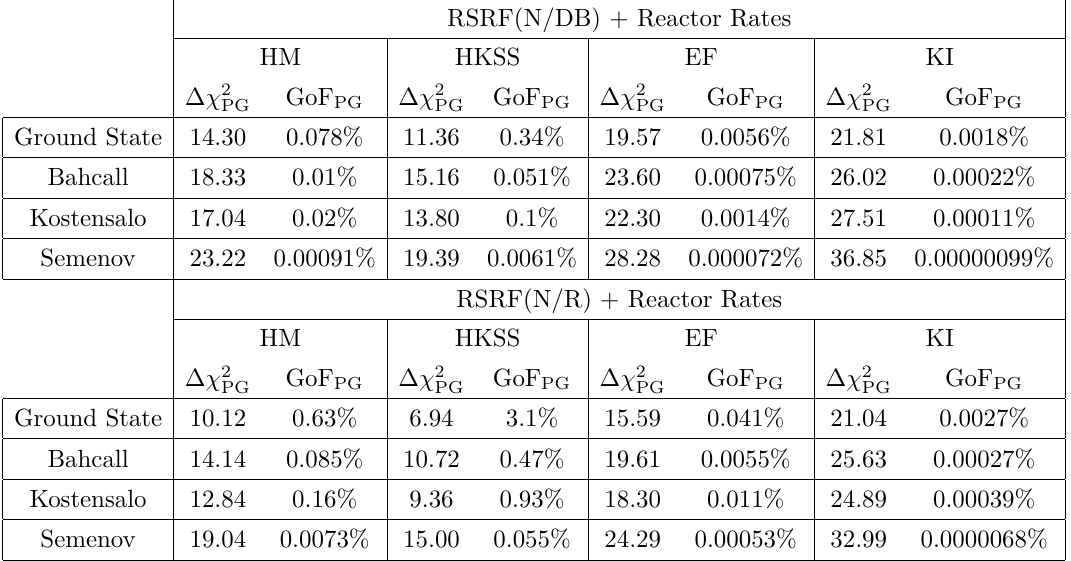
Table 4. χ 2 difference ∆ χ 2 of the parameter goodness of fit test [36] applied to the comparison of PG the neutrino oscillation fits of the reactor rates and spectral ratio data with the Gallium data using the four Gallium detection cross sections in table 1. The values of the corresponding parameter goodness of fit GoF PG are calculated with two degrees of freedom corresponding to the two com- mon oscillation parameters sin 2 2 ϑ ee and ∆ m 2 . The column titles RSRF(N/DB) and RSRF(N/R) 41 indicate, respectively, the combined fits of NEOS/Daya Bay and NEOS/RENO data with those of the other reactor spectral ratio experiments discussed in the text (DANSS, PROSPECT, STEREO, and Bugey-3). The column titles HM, HKSS, EF, and KI refer to the four reactor neutrino fluxes discussed in section